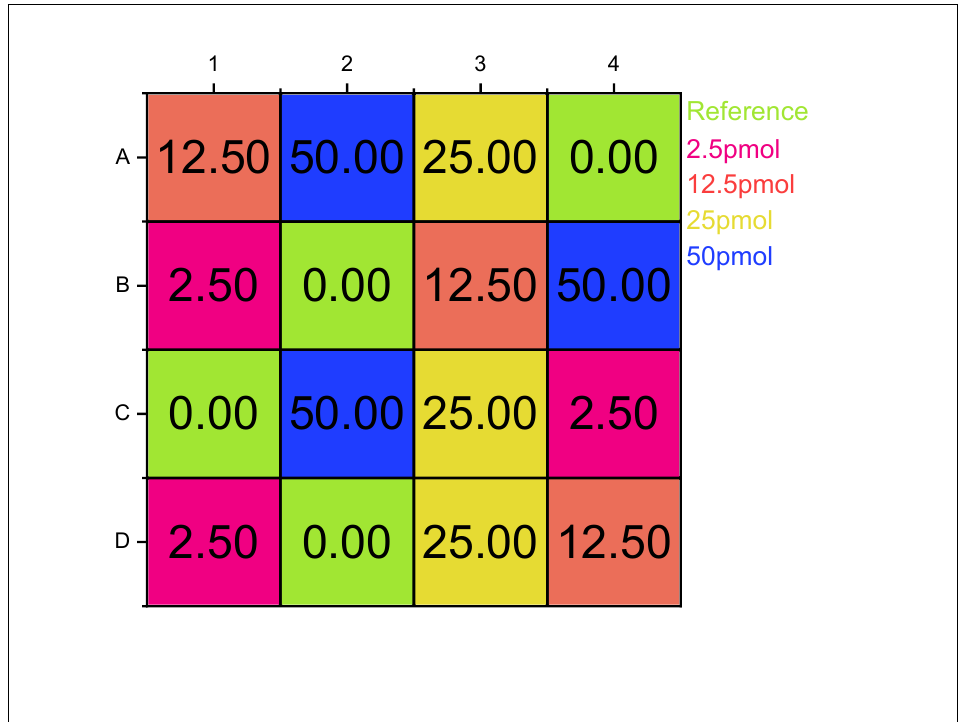
Figure A1. Occupation scheme for the 0.3THz biosensors. The number in each query field indicates the deposited amount of substance for each